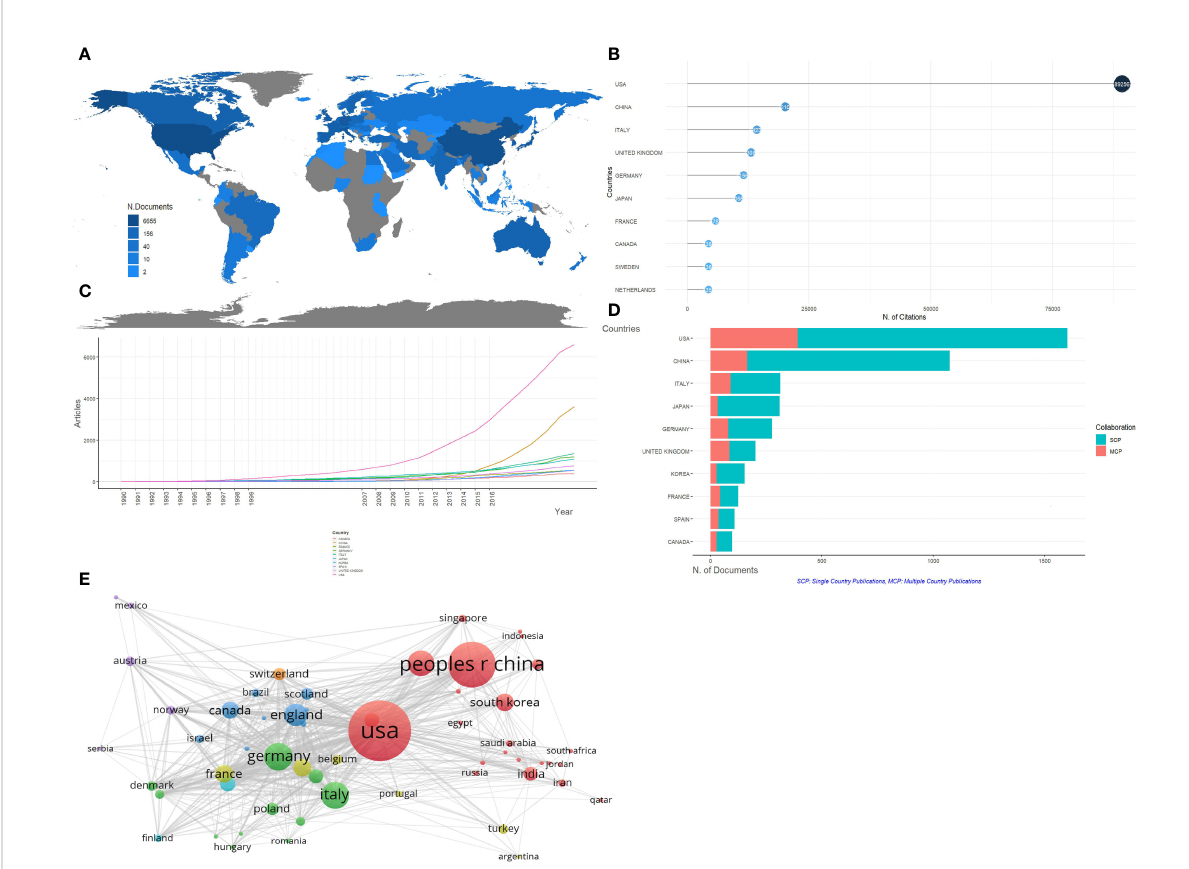
FIGURE 3 Analysis of countries/regions concerning research on pancreatic cancer metabolism. (A) Geographical distribution of global output; (B) Visualization map of the top 10 productive countries/regions; (C) Annual output trend of the top 10 productive countries/regions; (D) Countries/ regions in the top 10 of centrality; (E) Visual cluster analysis of cooperation among